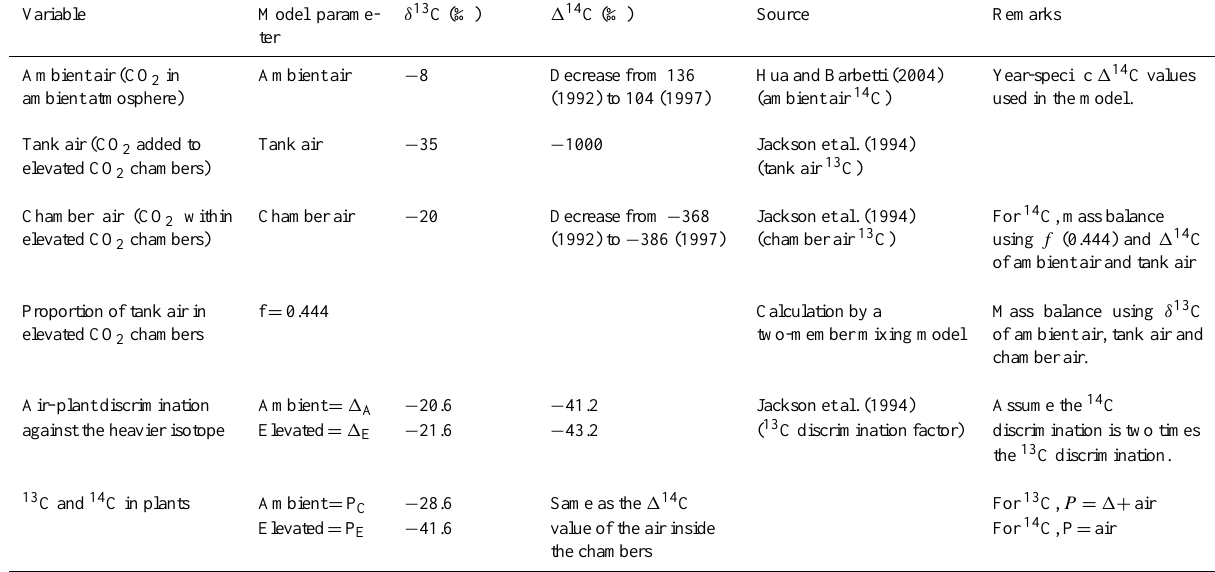
Table 1. Isotopic signature of ambient/tank air and plant inputs used in the model. δ 13 C (‰) Variable Model parame- ter